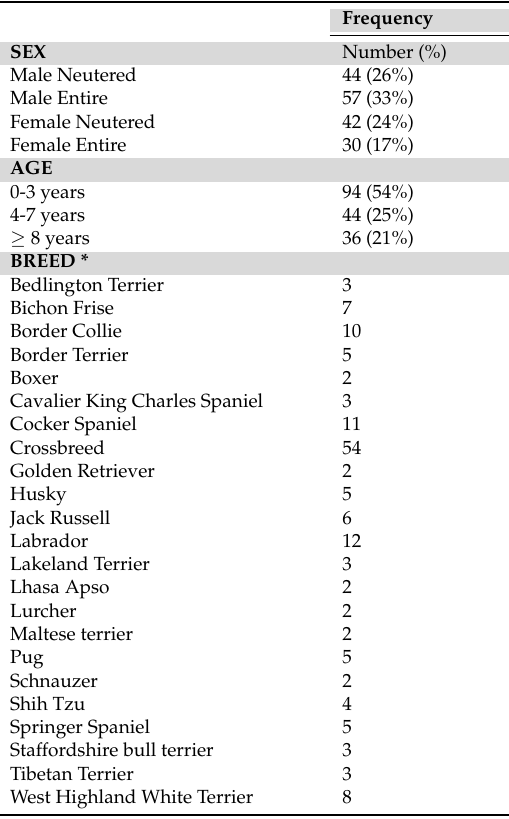
Table 1. Signalment of dogs included in